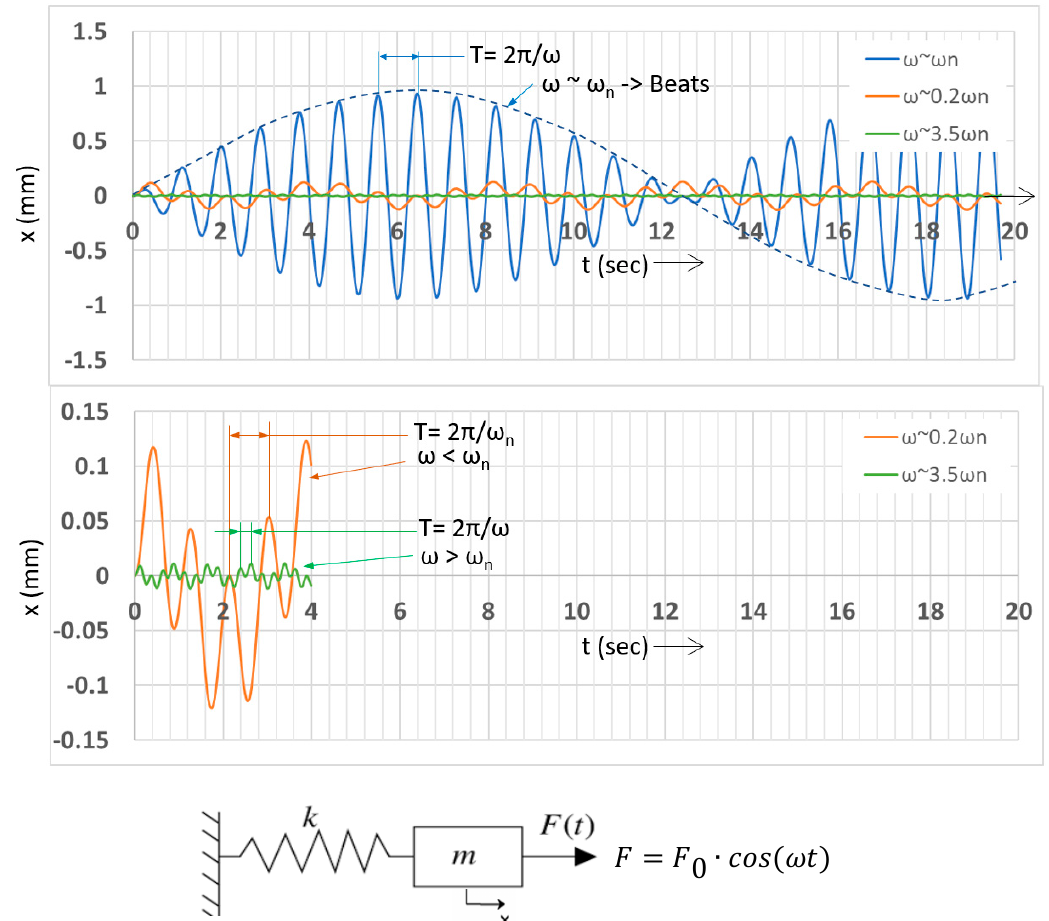
Figure A1. Spring and mass response to harmonic excitation (vibration). Top plot: Three di ff erent responses where the only parameter changed is the excitation frequency. The results are plotted on the same graph for ω ~ ω n (blue), ω < ω n (orange), and ω > ω n (green). Bottom plot: Showing only the ω < ω n (orange) and the ω > ω n (green) plots with corrected ordinate (abscissa is the same).